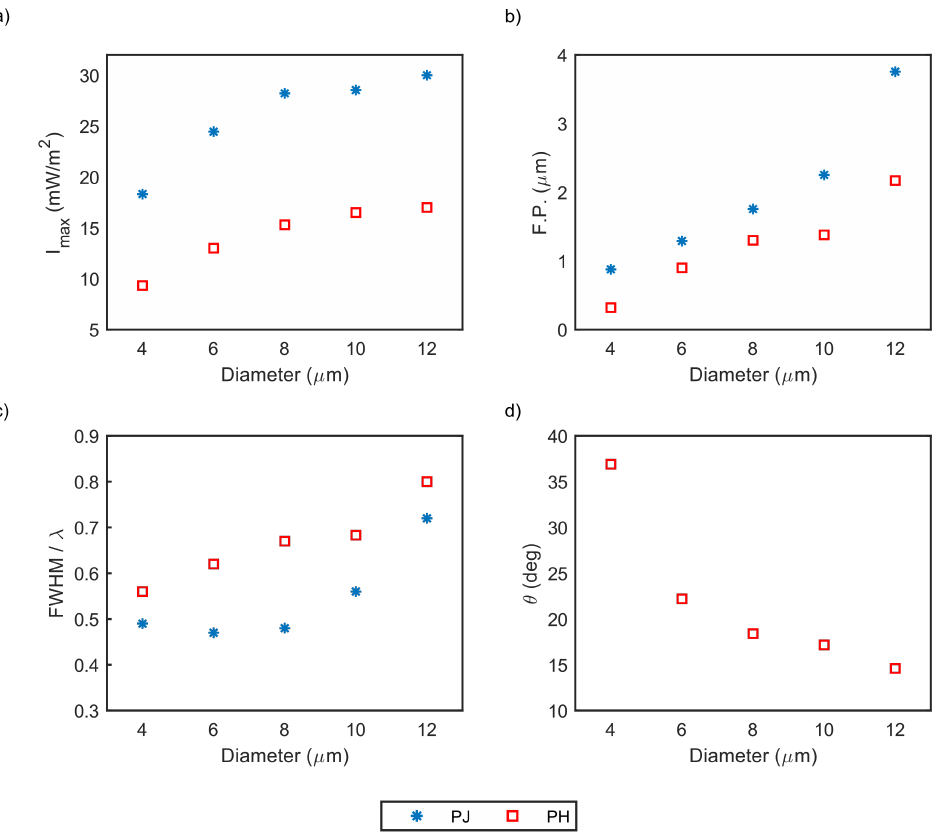
Figure 5. PNJ and PH characterized parameters as a function of the silica microcylinder diameter, which is illuminated by a 637 nm continuous plane-wave in the x -direction. ( a ) Maximum intensity for PNJ (blue) and PH (red) ( b ) Focal point (F.P.) for PNJ (blue) and PH (red) measured from the center of the microcylinder that is located on axes-origin ( c ) FWHM for PNJ (blue) and PH (red) related to the incident wavelength ( λ ) ( d ) PH tilt angle ( θ ) in